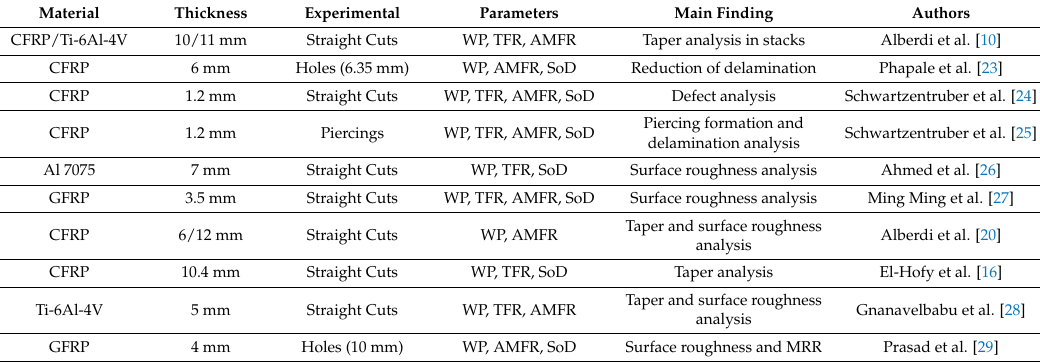
Figure 1. Scheme with the main defects associated with Abrasive Waterjet Machining (AWJM): ( a ) Erosion affected zone and kerf taper defined by inlet width (Wt) and outlet width (Wb); ( b ) different roughness zones that can be formed in AWJM. Table 1. Comparative table with AWJM experimental studies on aeronautical